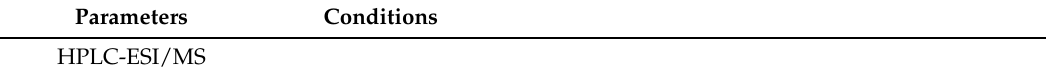
Table 4. Conditions to isolate and identify justicidin B by HPLC-ESI/MS